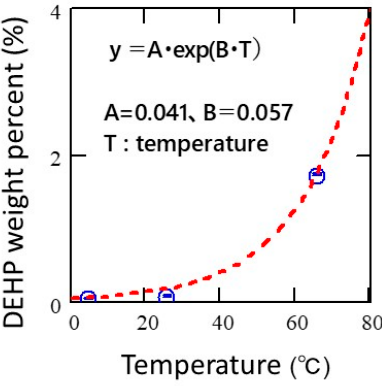
Figure 5. The change in DEHP weight percent due to temperature-dependent migration after 17 h of contact with plasticized PVC.